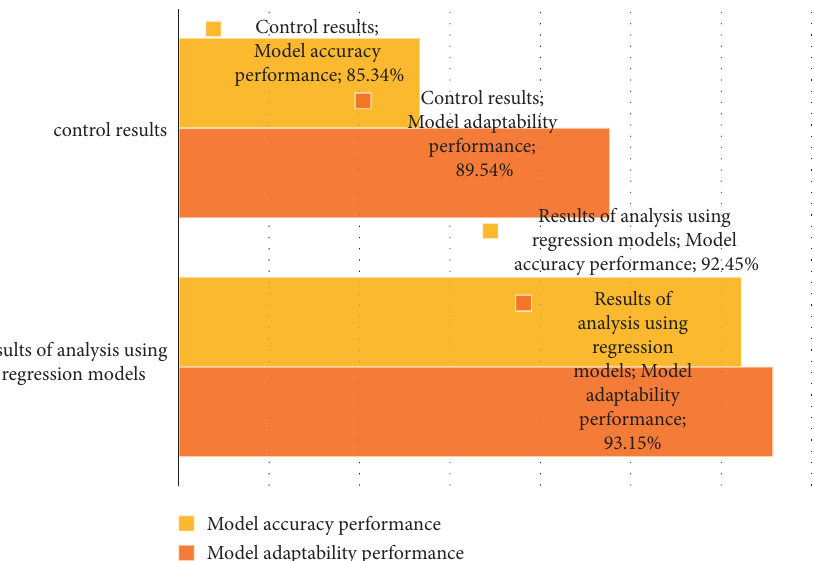
Figure 9: Comparison of conclusions of different logistic models.